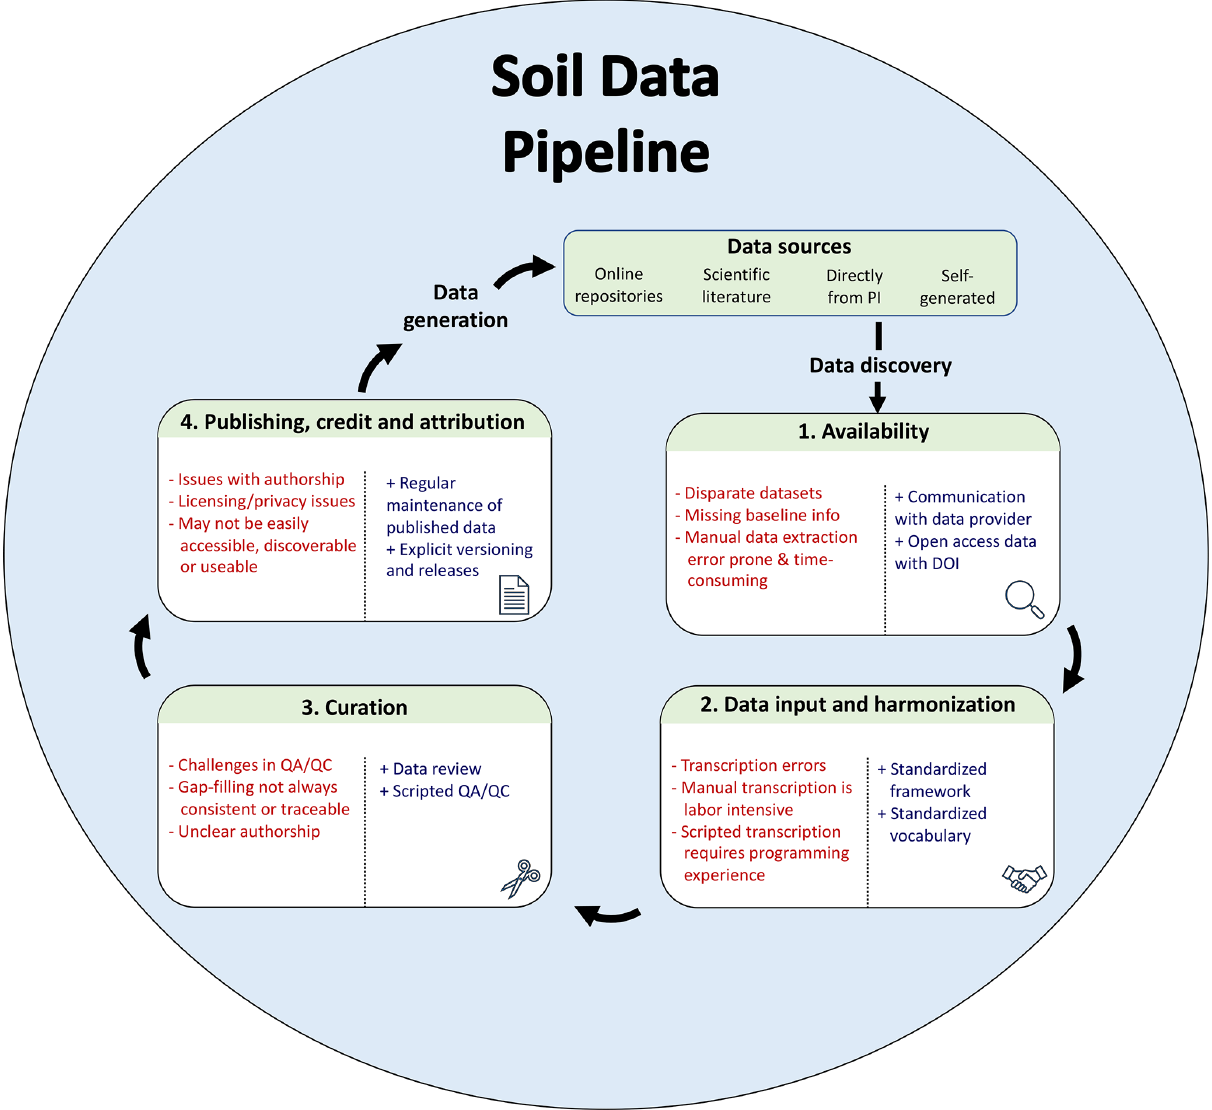
Figure 1. Database pipeline with pain points (indicated by “ − ”) and suggestions for improvement (indicated by “ + ”) to conform more closely to FAIR data principles. Data sources can be diverse, including published (online repositories and scientific literature) and unpublished sources (direct from principal investigator, PI). After these sources have been discovered, the data must be accessed and harmonized according to a standard format or data model (internal to the project or a community-driven standard). The aggregated data must then be curated before ultimately being published for